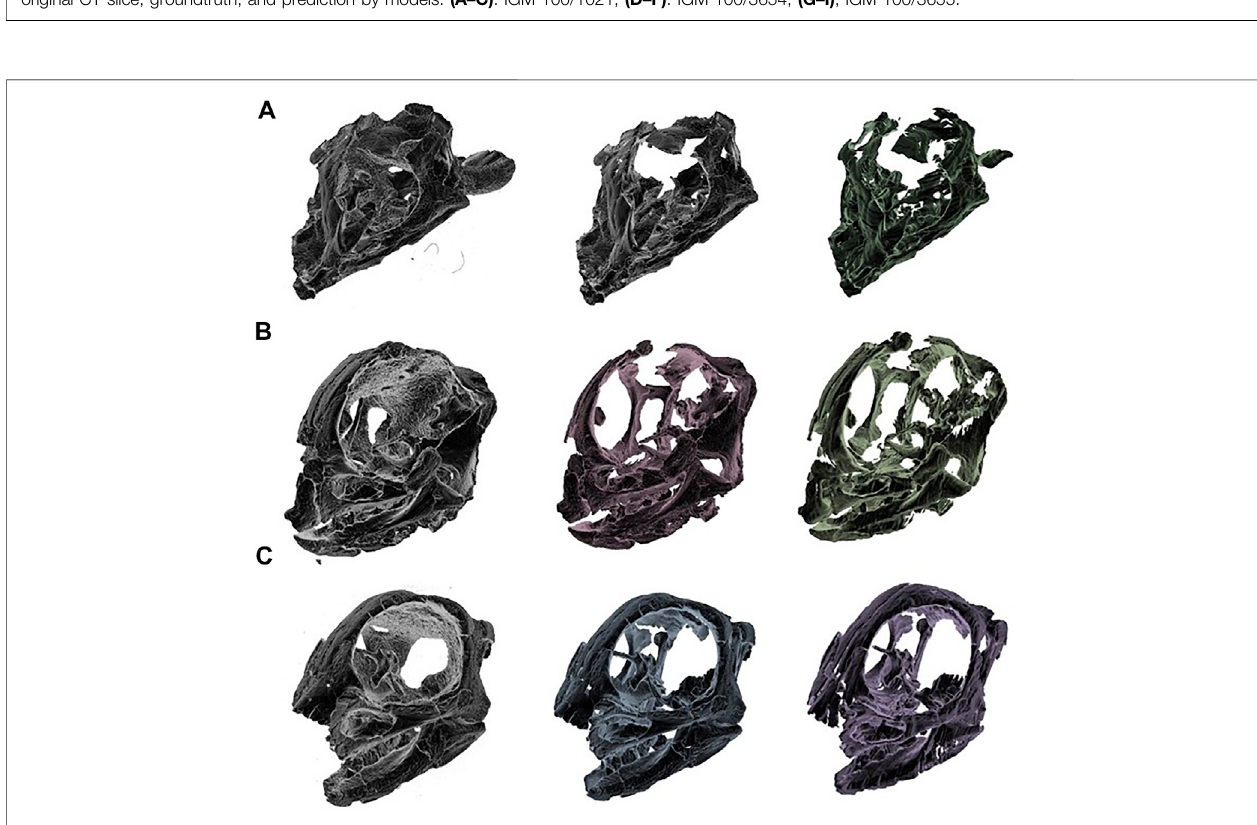
FIGURE 5 | Comparison of different 3D renderings. From left: raw reconstruction (after thresholding), manual segmentation, and deep learning segmentation (by Deeplab v3+MobileNet v1) (A) IGM 100/1021 (B) IGM 100/3654 (C) IGM 100/3655.